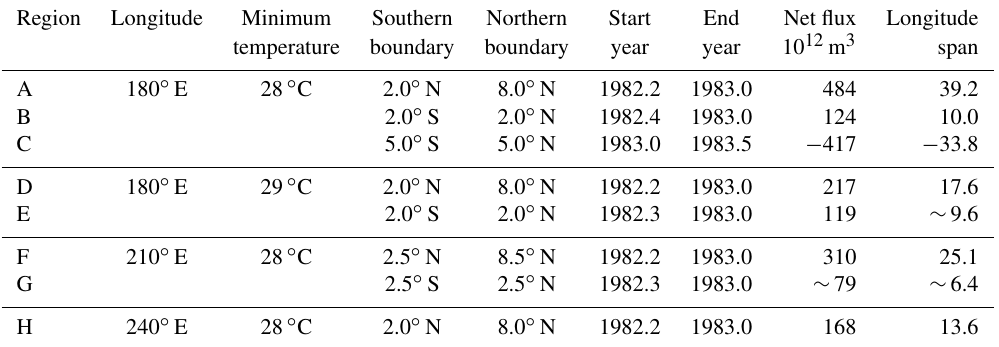
Table 1. Volume transport of water for the longitudes, temperature classes, latitude bands and time periods denoted in Fig. 7. The net flux is given both in units of 10 12 m 3 and in terms of the number of degrees longitude that would be covered by the same volume if it was in a layer 100m thick which extended from 5 ◦ S to 5 ◦